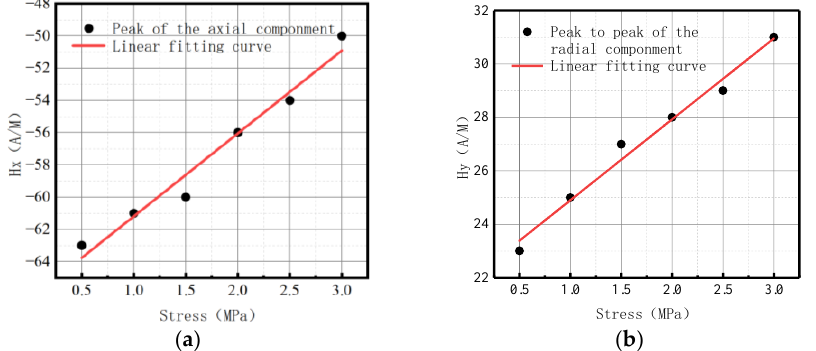
Figure 36. Peak value varies at the crack of base metal with internal pressures. ( a ) Peak values of the axial component; ( b ) peak-to-peak values of the radial component.